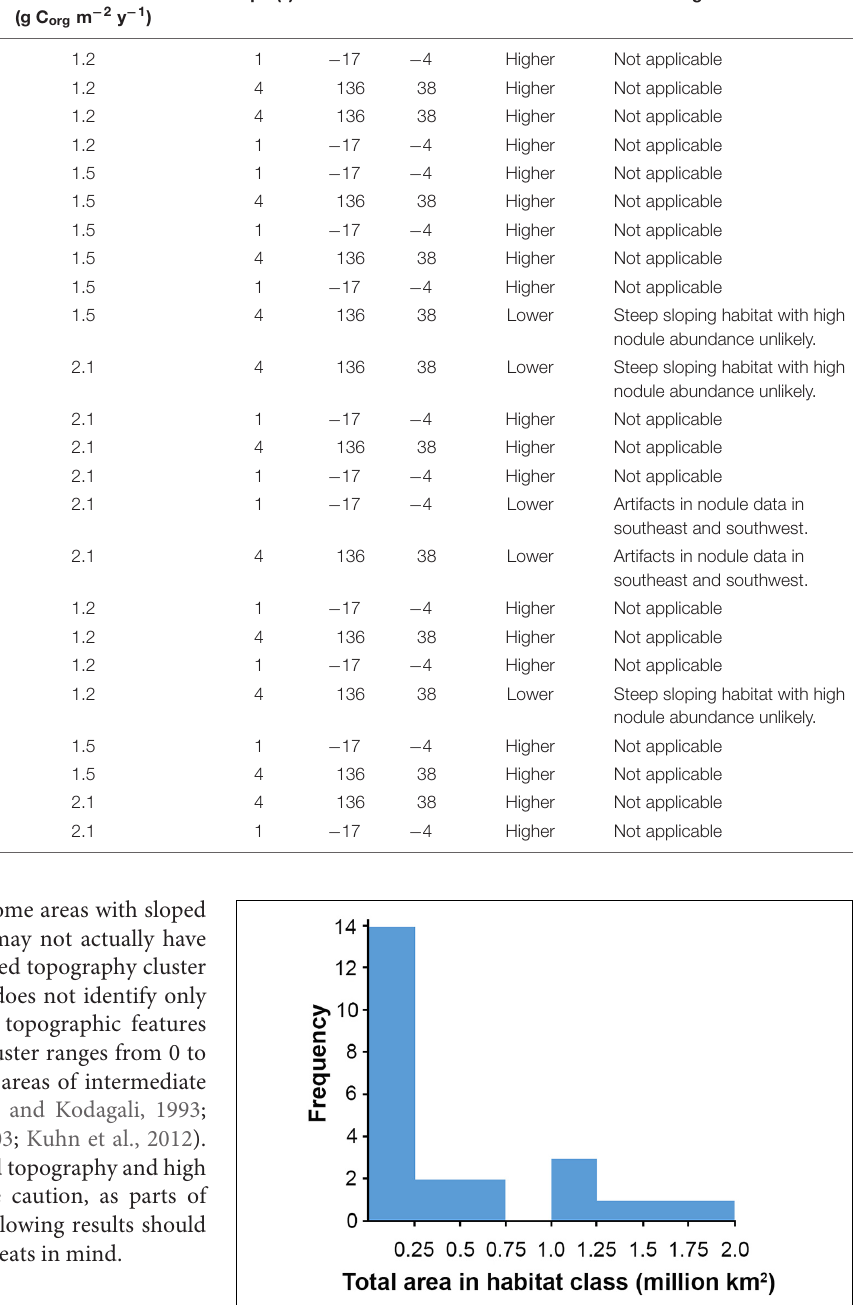
TABLE 3 | Environmental characteristics (mean values) of each habitat class, indicating confidence with which the class should be treated. Habitat class